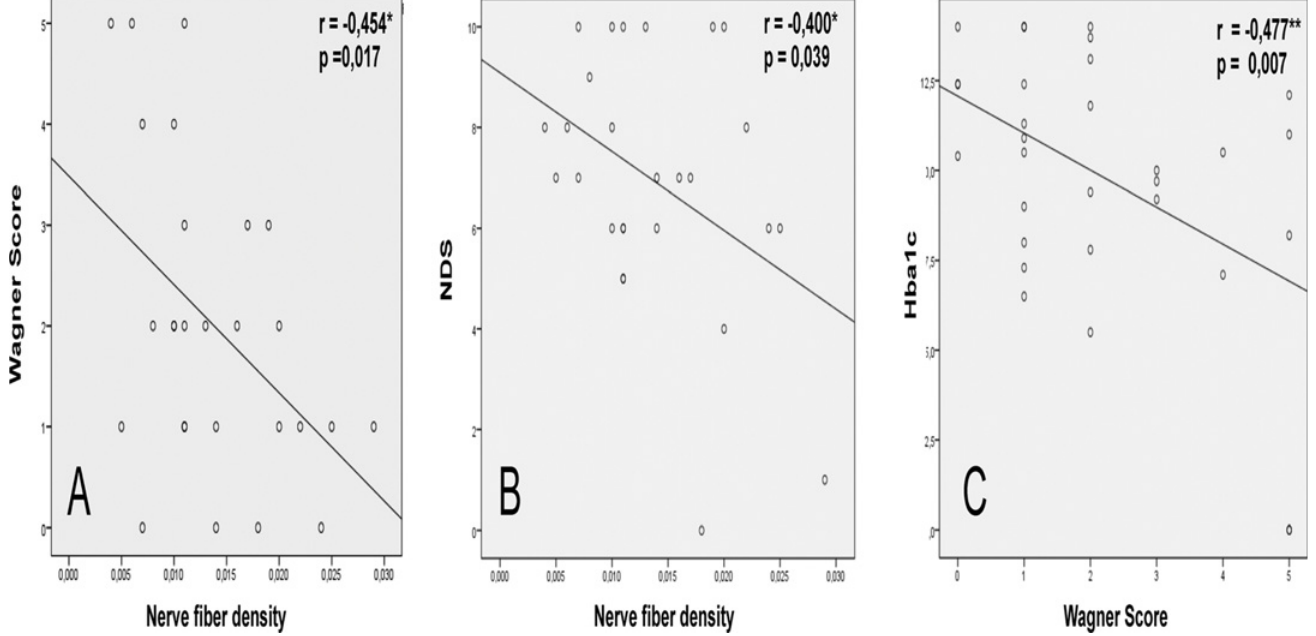
Fig 2. Correlation of study parameters. ** Correlation significant 0,01 (bilateral). * Correlation significant 0,05